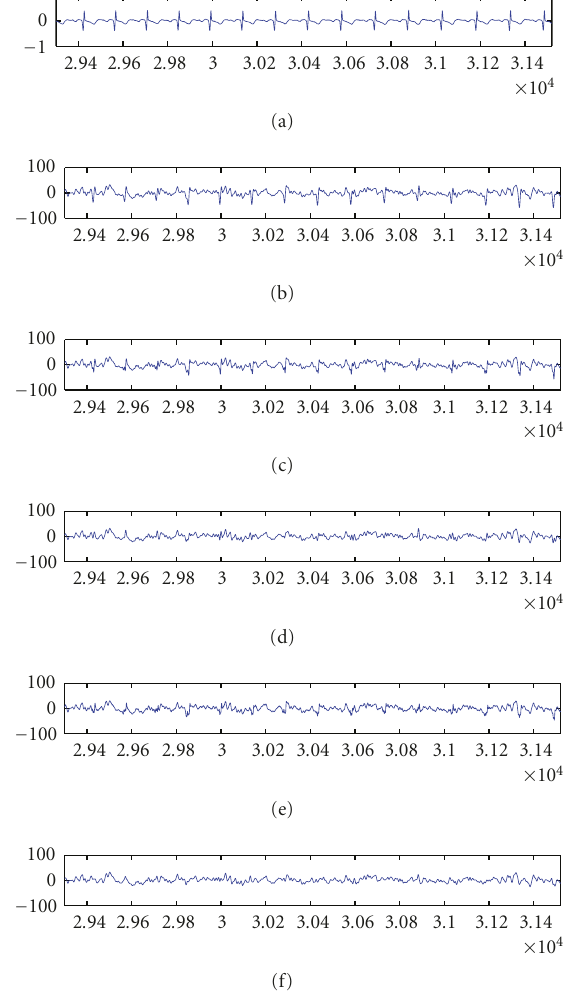
Figure 20: Results obtained on a 15 seconds excerpt from patient 4: (a) ECG, (b) corrupted signal, (c) correction by AF-ECG, (d) correction by AF-EA, (e) correction by ICA-ECG and (f) correction by